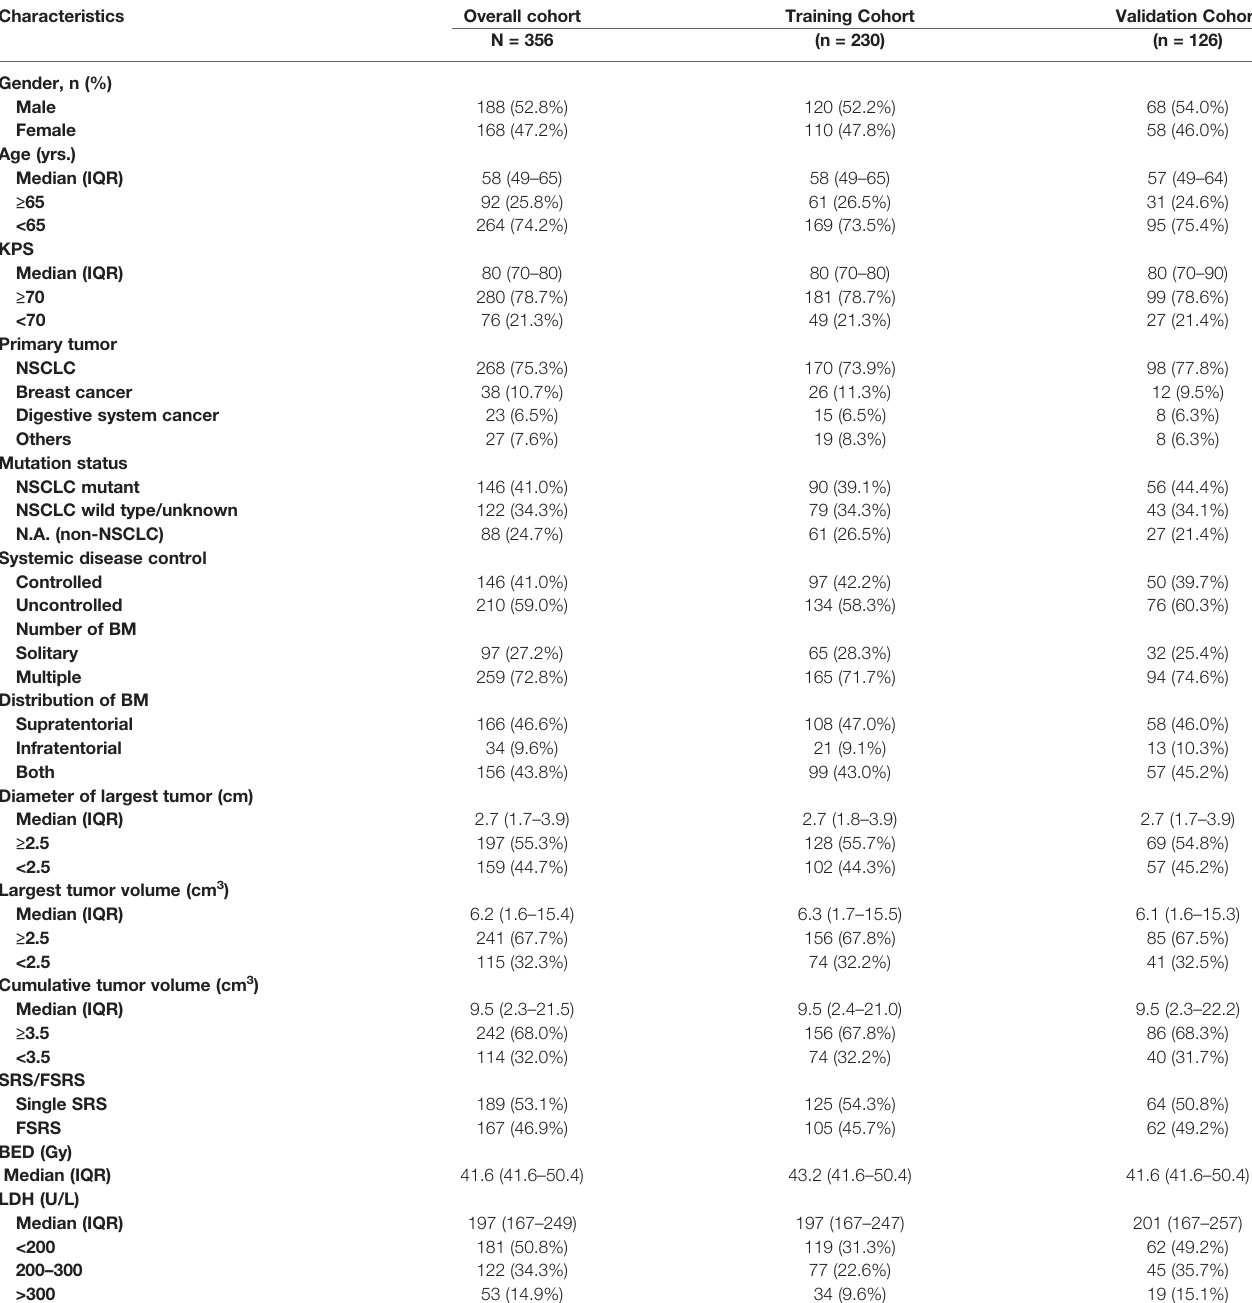
TABLE 1 | Demographics and clinical characteristics of the study